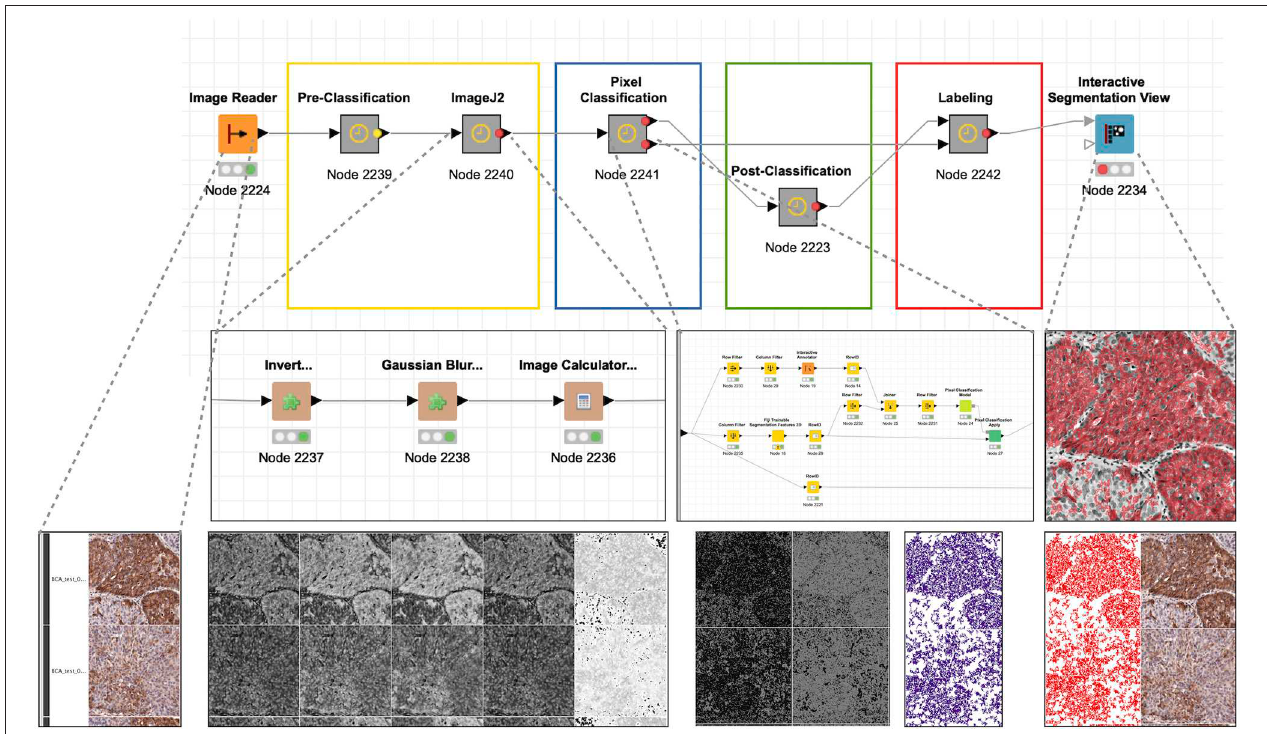
FIGURE 6 | Quantitative analysis of histological stain. The histological staining of a cell adhesion marker (CD166) related to tumor invasion and metastasis demonstrates significant variation across patient samples. As in user case no. 1, the KNIME workflow was divided into sequential steps that complete discrete objectives: (1) read in file, (2) preprocessing of the images and their annotation in preparation for analysis using ImageJ2 functionalities, (3) pixel classification using Weka-bases machine learning functionality, (4) post-classification processing of image data to labels that correspond to “positive,” (5) compilation of labels, images, and annotations, (6) visualization of the quantitation by overlaying the labels with the original